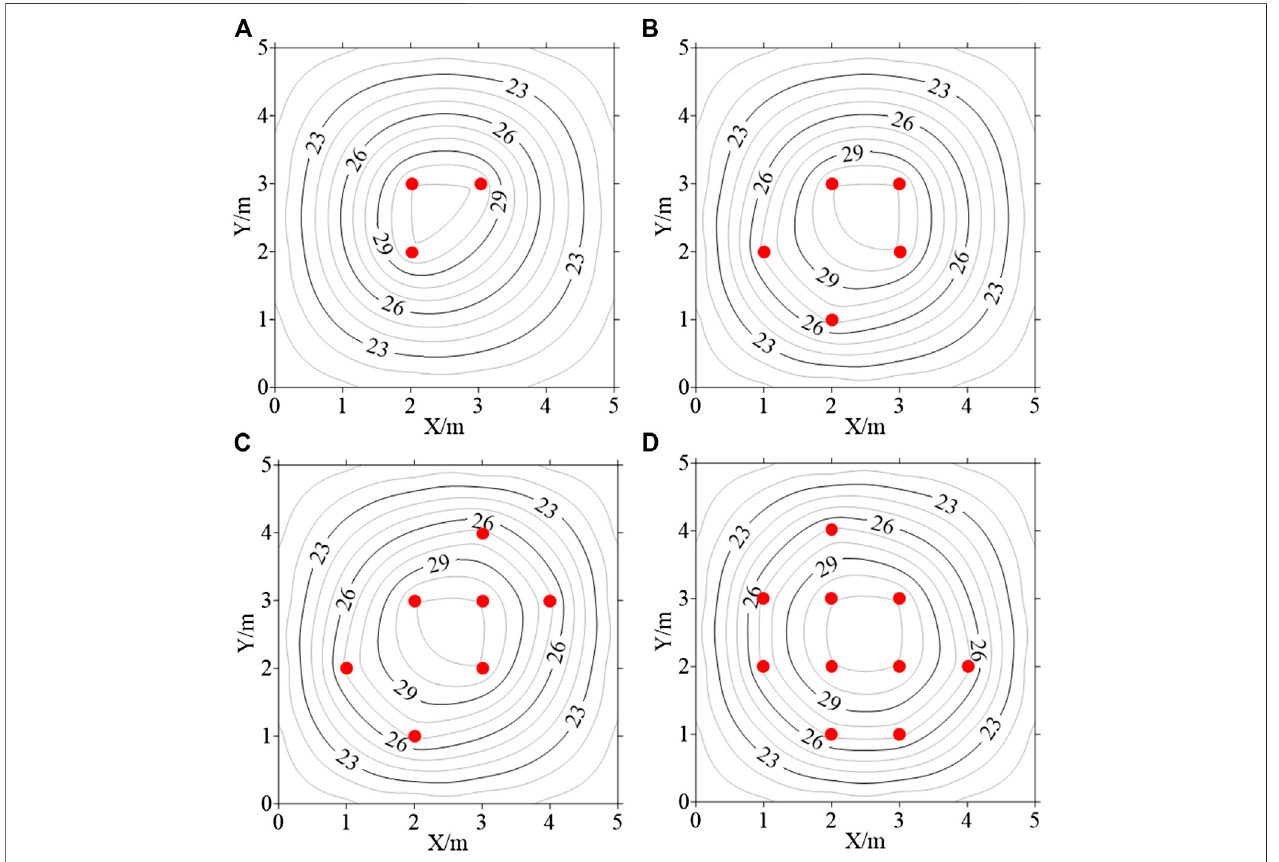
FIGURE 5 | The restructured thermal fi eld of the concrete block: (A) m (cid:2) 3; (B) m (cid:2) 5; (C) m (cid:2) 7; (D) m (cid:2) 10 (the red points represent temperature sensors).